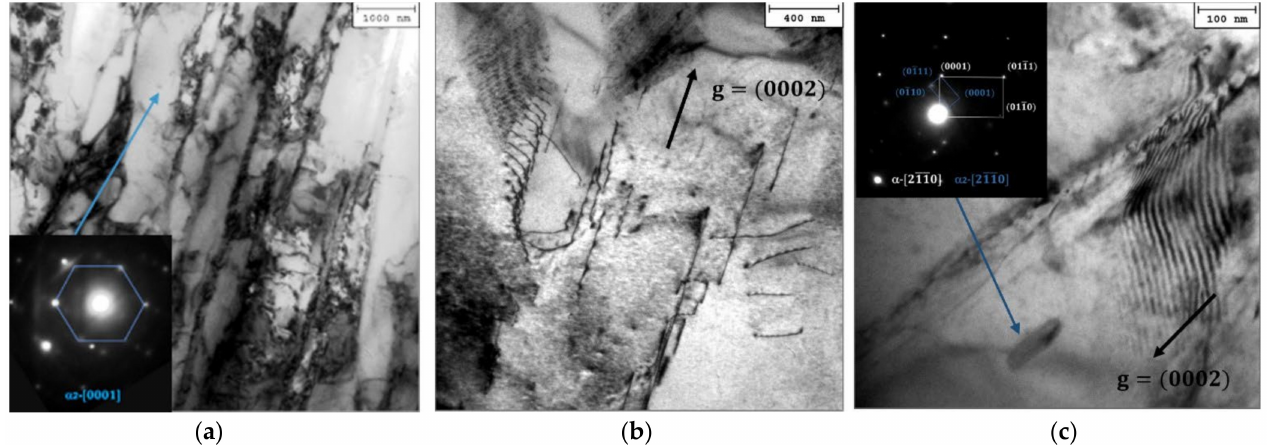
Figure 4. Representative TEM micrographs of the initial microstructure. In ( a ) typical lamellar structure of α , α (cid:48) , and β is reported, with the inset showing SAEDP of α in its [0001]-zone axis; ( b , c ) refer to the same α -[2110 ] -zone axis. In ( c ), the inset shows indexed SAEDP taken at the α / α 2